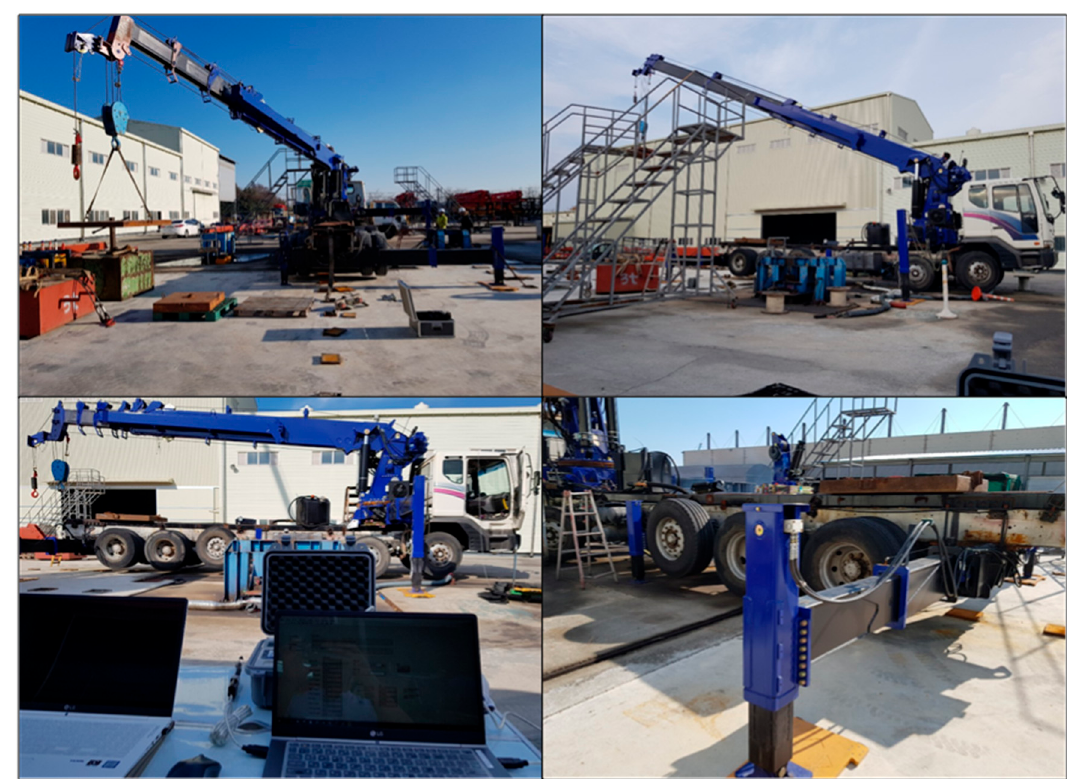
Figure 9. Measuring the reaction force of mobile crane.